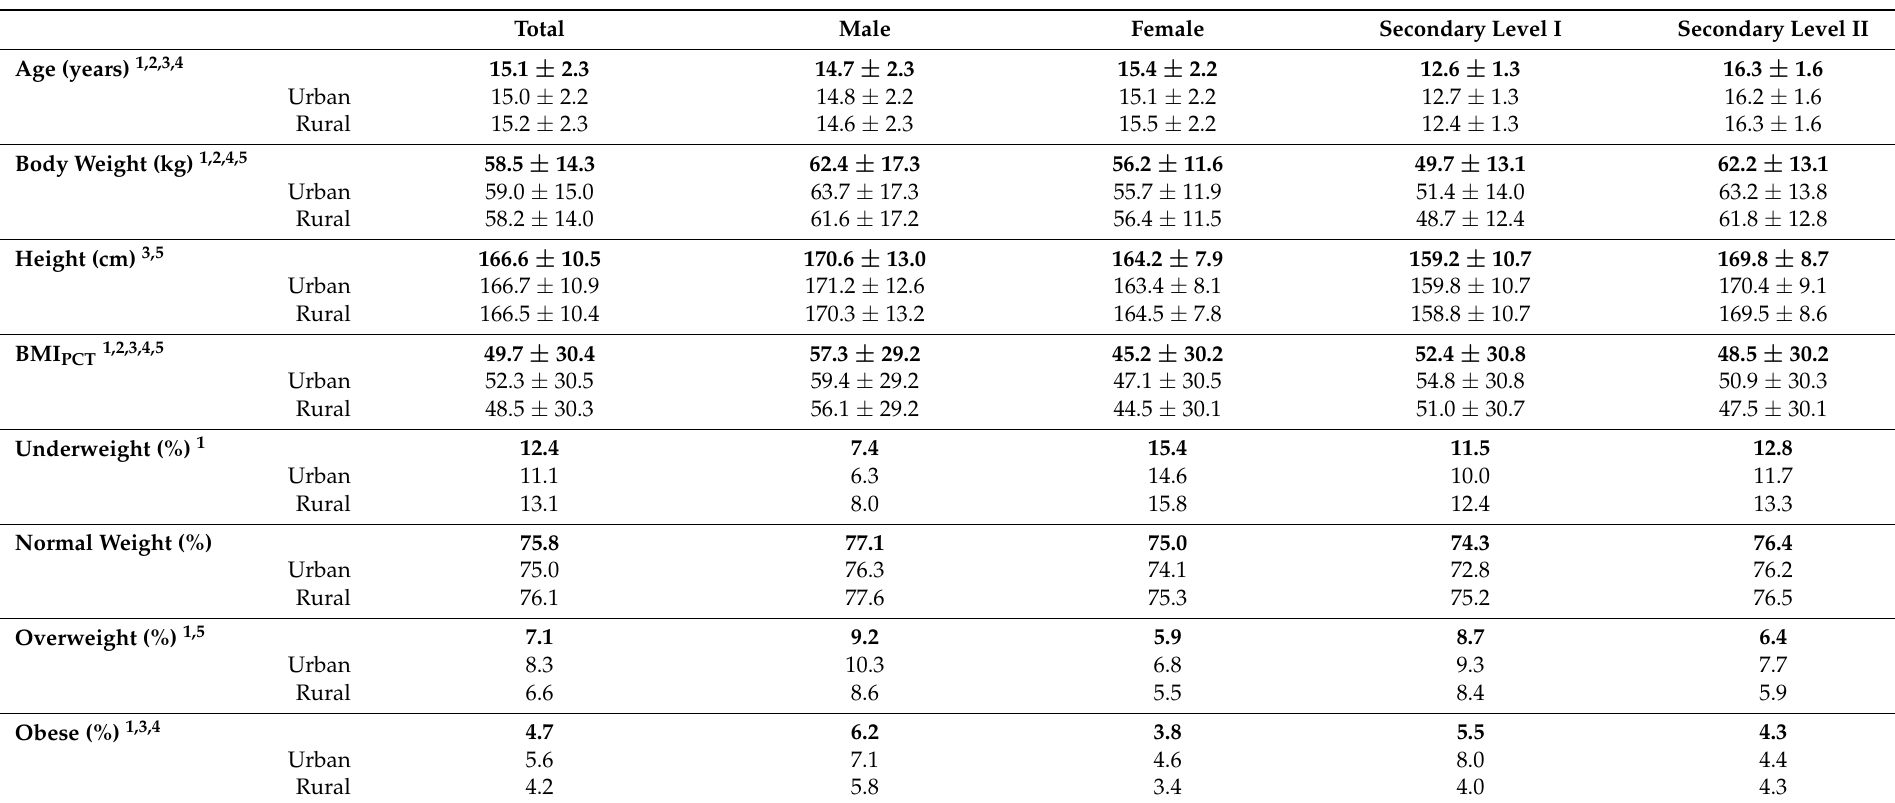
Table 2. Anthropometric characteristics for the total sample and separately for male and female participants as well as secondary level I and secondary level II. Values are means ± SD and prevalence for weight